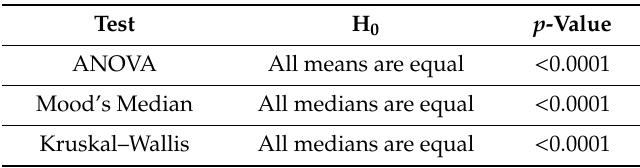
Table 2. Statistical Analysis